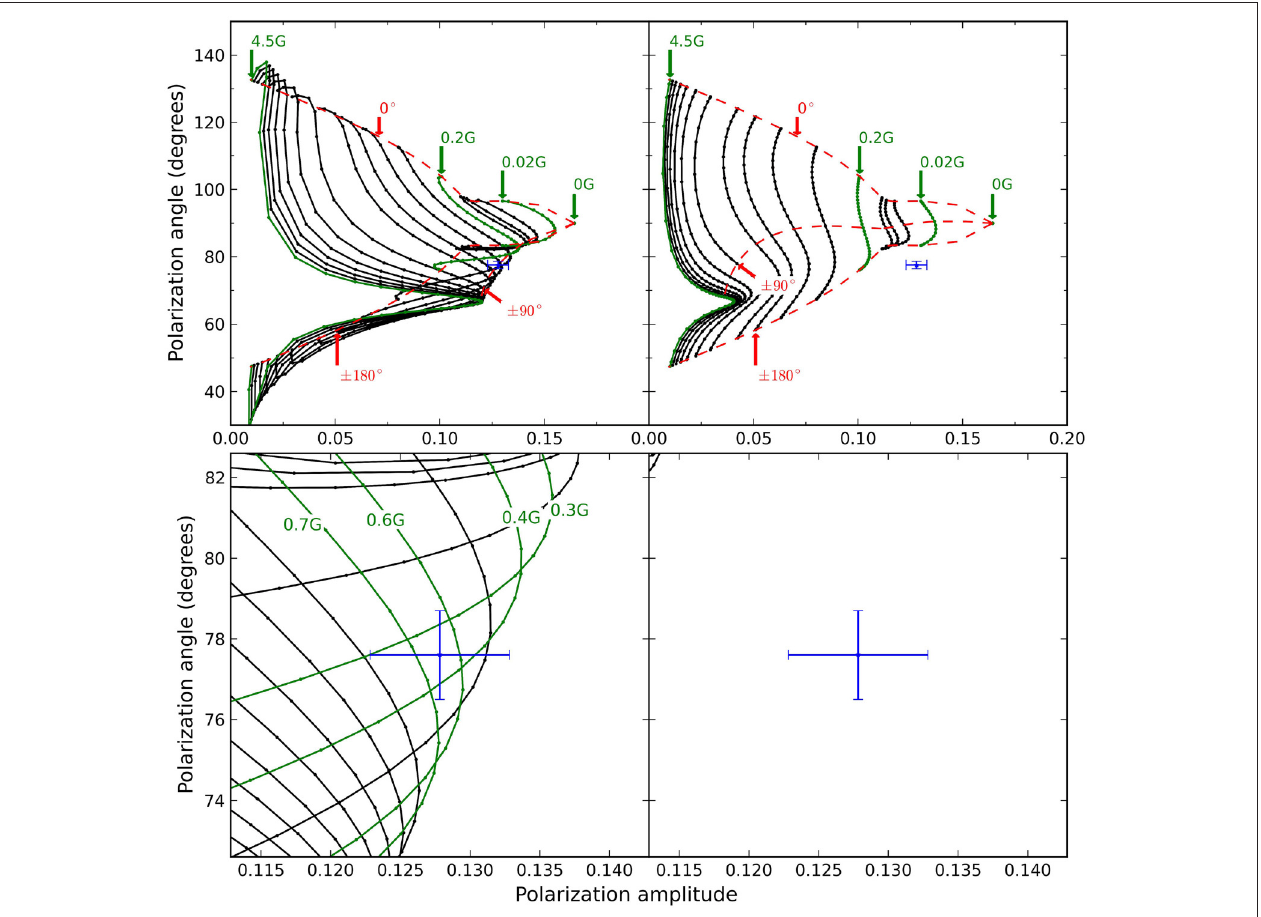
FIGURE 3 | Field I model grids for HeI1083 linear polarization with polarization angle drawn against polarization amplitude. B-isocontours are drawn as solid black lines. The top panel shows the entire solution space with some B-isocontours highlighted and labeled in green three χ B -isocontours drawn with red dashed. The bottom panel shows an enhanced region around the measured value for Field I with some B-isocontours highlighted in green. The B-isoncotours in the bottom panel are all separated by 0.1G. For both the top and bottom panels the left plot shows the model grids for plane of polarization parallel to the field projection, while the right plot shows the grid for the plane of polarization perpendicular to the field projection. The measured HeI1083 polarization value for Field I is drawn in blue with errors bars corresponding in size to intensity errors ∼ 0.5 %. For Field I the measurement intersects only the parallel grid. This is consistent with an inclination measurement outside the Van Vleck uncertainty